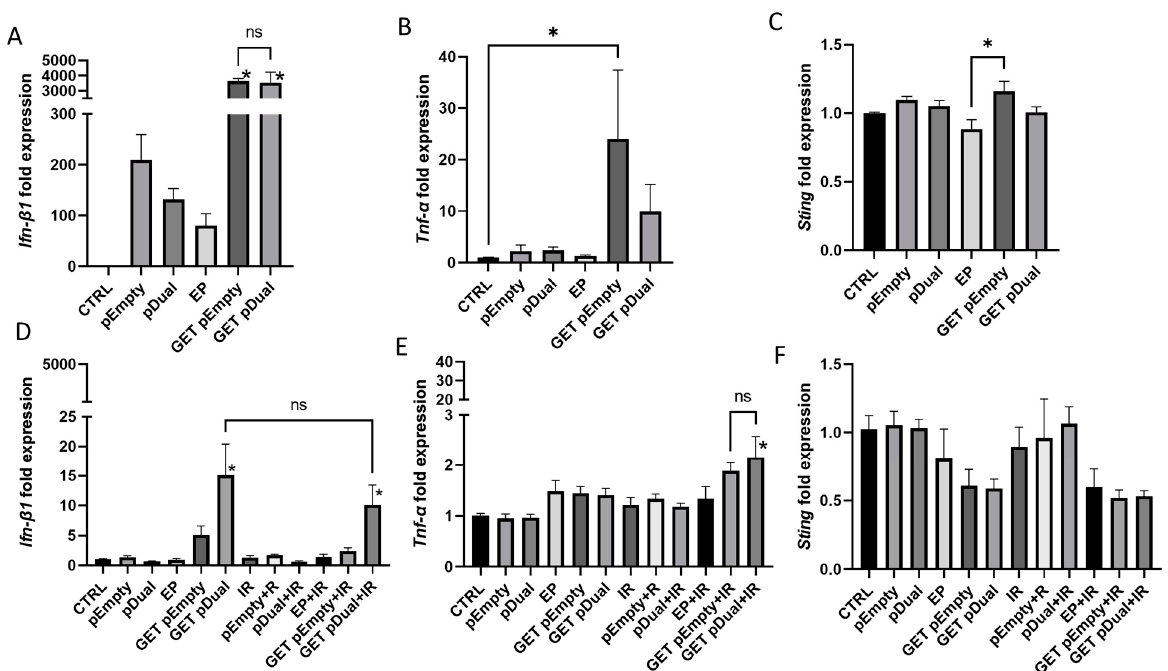
Figure 5. Expression of cytokines Ifn- β 1 and Tnf- α and DNA sensor Sting after pU6-anti-CD105-146-ORT GET alone or in combination with IR. Expression of Ifn- β 1 ( A ), Tnf- α ( B ) and Sting ( C ) 4 h after pU6-anti-CD105-146-ORT GET. Expression of Ifn- β 1 ( D ), Tnf- α ( E ) and Sting ( F ) 48 h after pU6-anti-CD105-146-ORT GET and 24 h after IR. Bars represent the mean ± standard error of mean for three independent experiments. Values are normalized to the control group. *, statistically significant difference vs. all groups ( p < 0.05). ns, statistically non-significant difference. Group names: CTRL—untreated cells, pEmpty—treatment with pEmpty-ORT plasmid alone, pDual—treatment with pU6-anti-CD105-146-ORT plasmid alone, EP—application of electric pulses alone, GET pEmpty—GET of pEmpty plasmid, GET pDual—GET of pU6-anti-CD105-146-ORT plasmid, IR—IR with 5 Gy, EP + IR—application EP and IR with 5 Gy, GET pEmpty + IR—GET of pEmpty plasmid and IR with 5 Gy, pDual + IR—GET of pU6-anti-CD105-146-ORT plasmid and IR with 5 Gy.